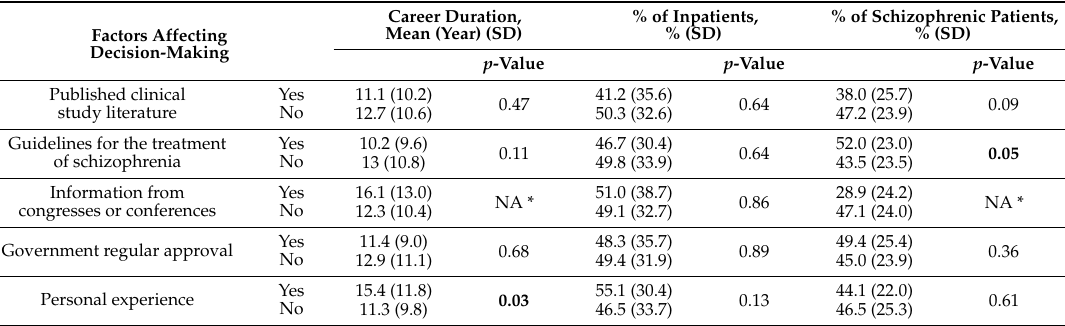
Table 3. Decision-making regarding treatment according to the practice characteristics of